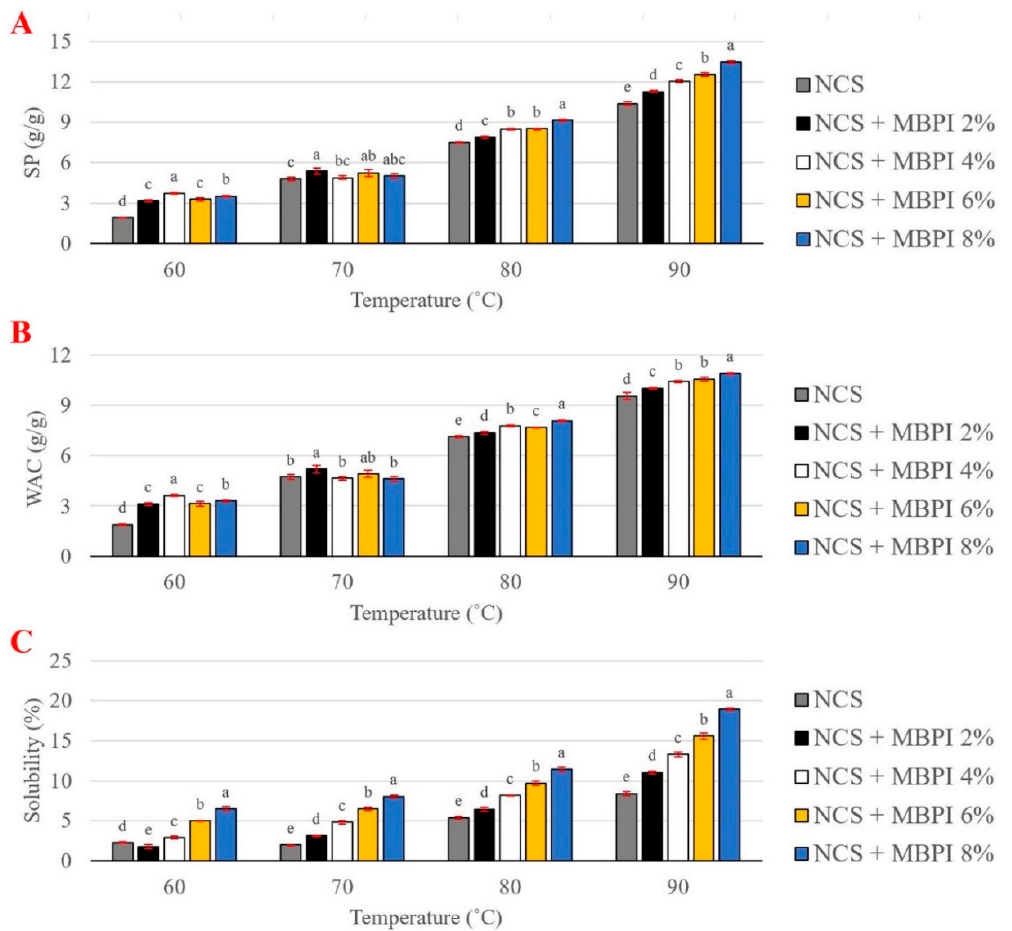
Figure 1. Swelling power ( A ); water absorption capacity ( B ); and solubility ( C ) of NCS and NCS/MBPI gels in different temperatures (60 °C, 70 °C, 80 °C, and 90 °C). Different letters at each NCS/MBPI gels in different temperatures (60 ◦ C, 70 ◦ C, 80 ◦ C, and 90 ◦ C). Different letters at temperature indicate significant differences ( p ) between treatments. each temperature indicate significant differences ( p ) between